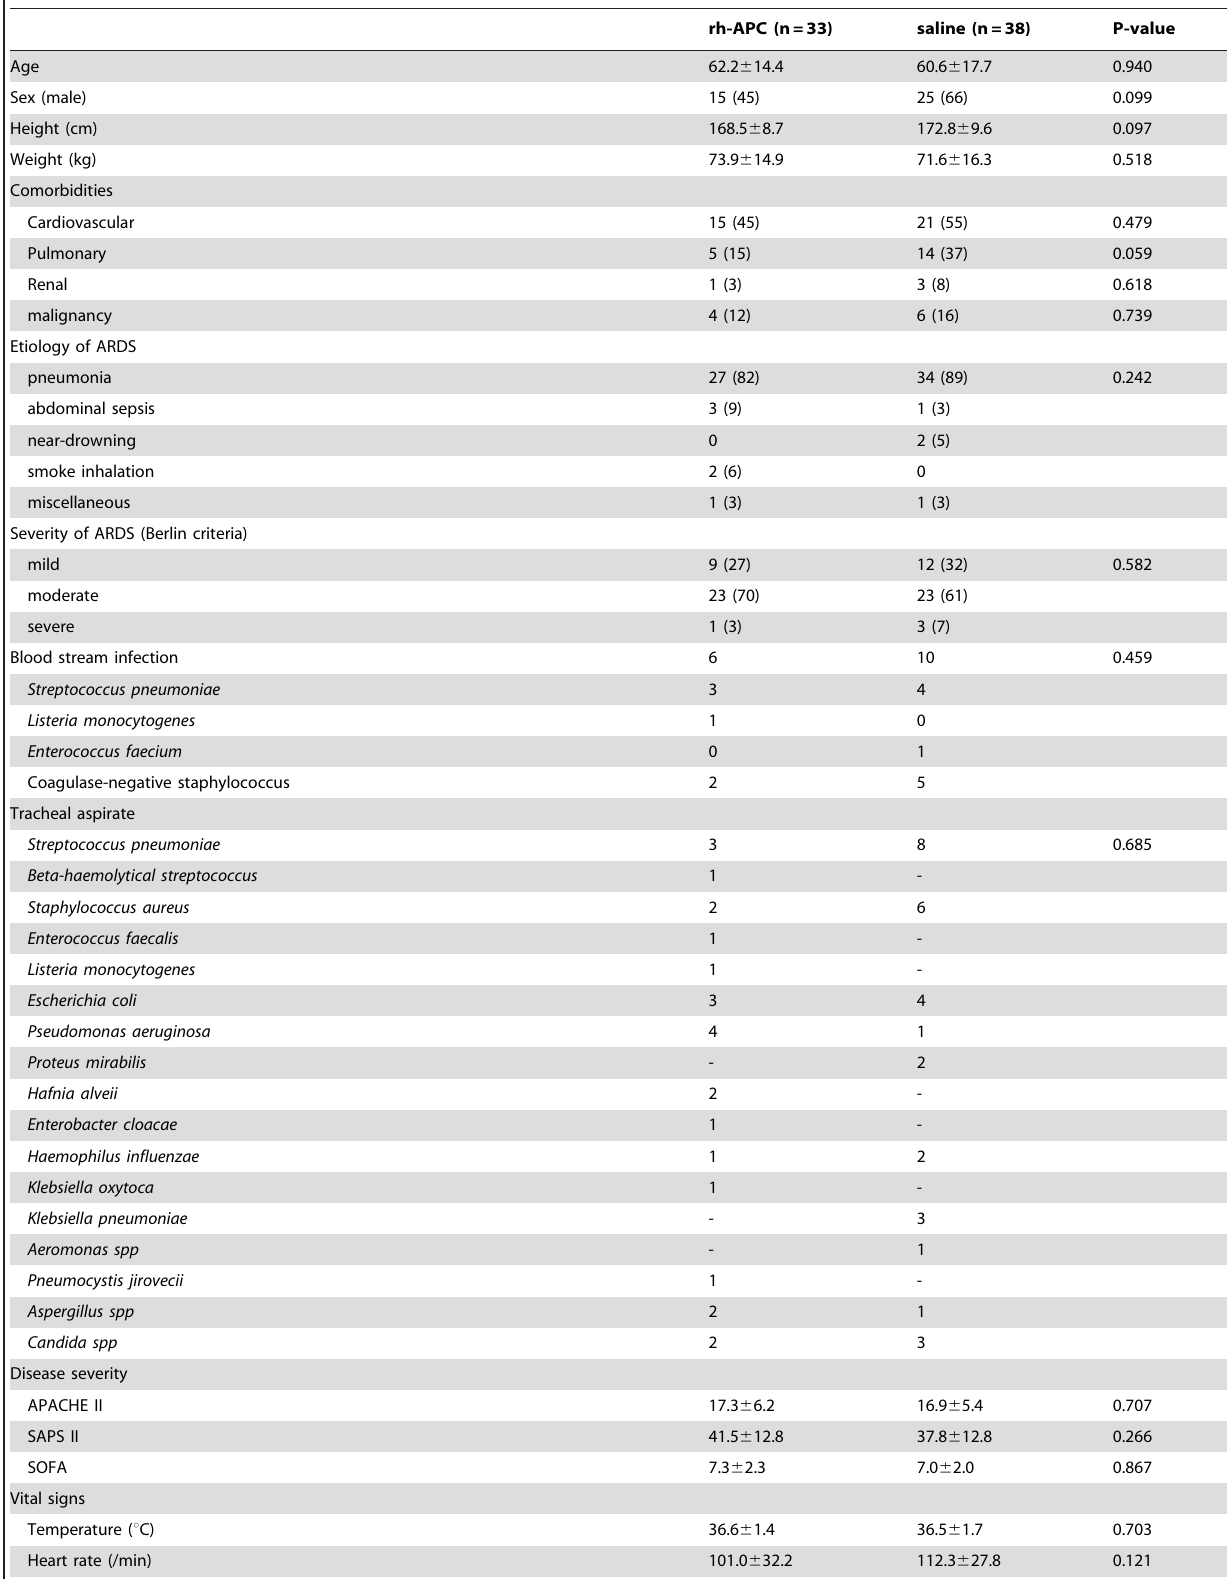
Table 1. Baseline